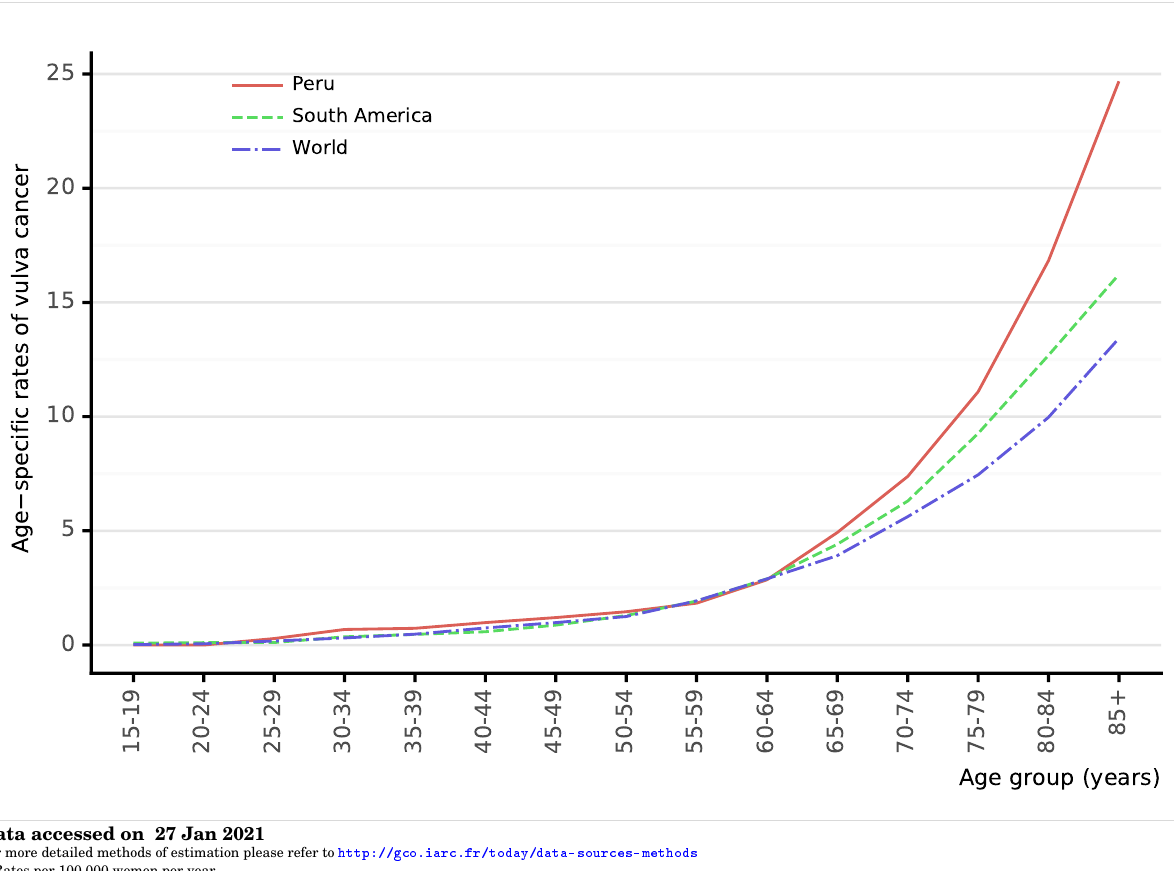
Figure 83: Comparison of age-specific vulva cancer incidence rates in Peru, within the region, and the rest of